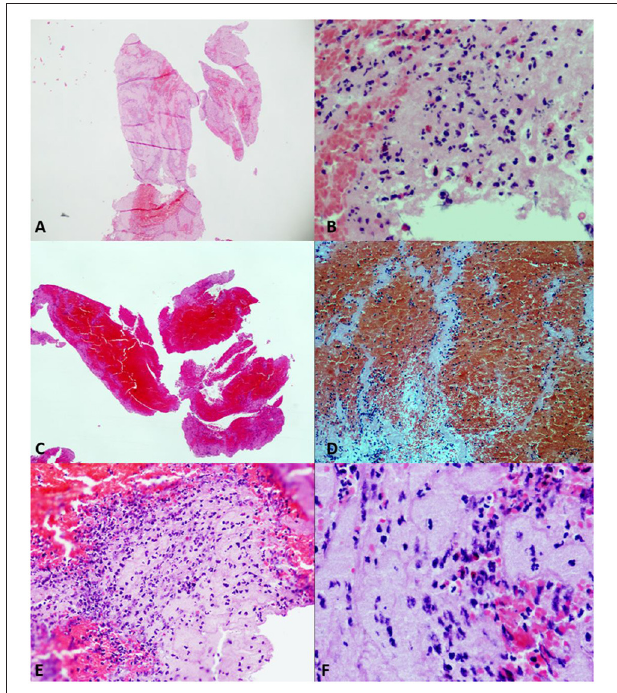
FIGURE 3 | Different samples of clots. Hematoxylin–eosin (HE) stain. (A) (HE2 × ) and (B) (HE20 × ). Platelet fibrin-predominant clot (FPC) with moderate number of complete neutrophils. (C) (HE2 × ) and (D) (HE20 × ). Red cell-predominant clot (RPC), with poorly formed Zahn lines. (E) (HE20 × ) and (F) (HE40 × ). Mixed clot (MC) with plenty of neutrophils, most of them of degenerated